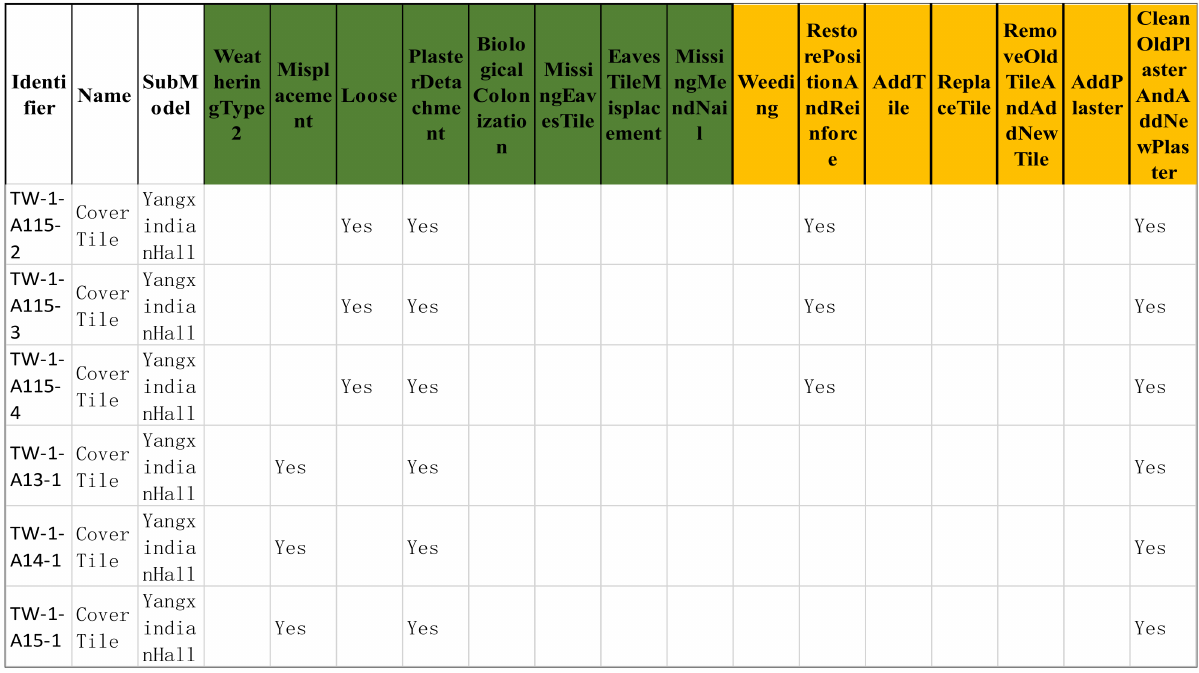
Figure 5. The part of the metadata